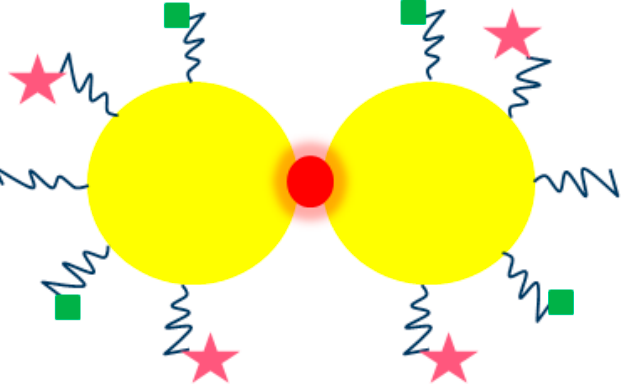
Figure 7. Au NPs dimers. Au NPs – yellow circles, DBDT – red circles, NH 2 -PEG-SH – blue wavy lines, peptide – green squares, and rhodamine – pink stars. (modified from Reference [86]).